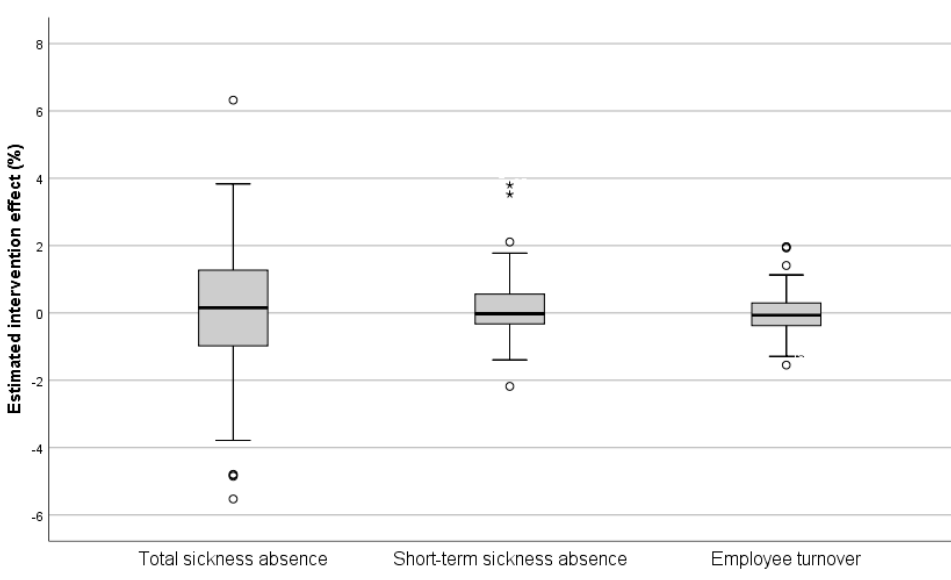
Table 2. Workplace-specific intervention effects on sickness absence and employee turnover expressed as the number of the 71 intervention groups with a statistically significant ( p < 0.05) intervention effect. In total and after adjustment for the concurrent development within the reference groups (removing workplace-specific interventions effects that could be explained by the general development in the operational area or department instead of the intervention).